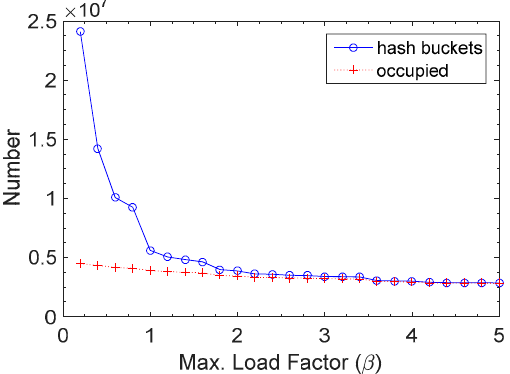
Figure 11. Comparison on the hash table size and the number of occupied buckets.